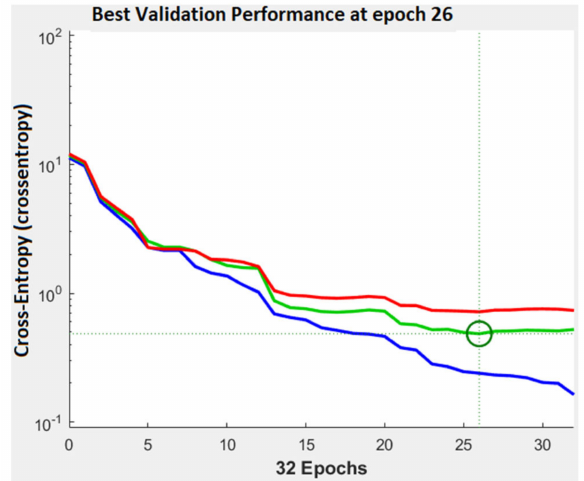
Figure 16. Training performance in case of ISIC 2019 database. Blue represents the training, green—the validation, red—the testing, and circle—the best validation performance.